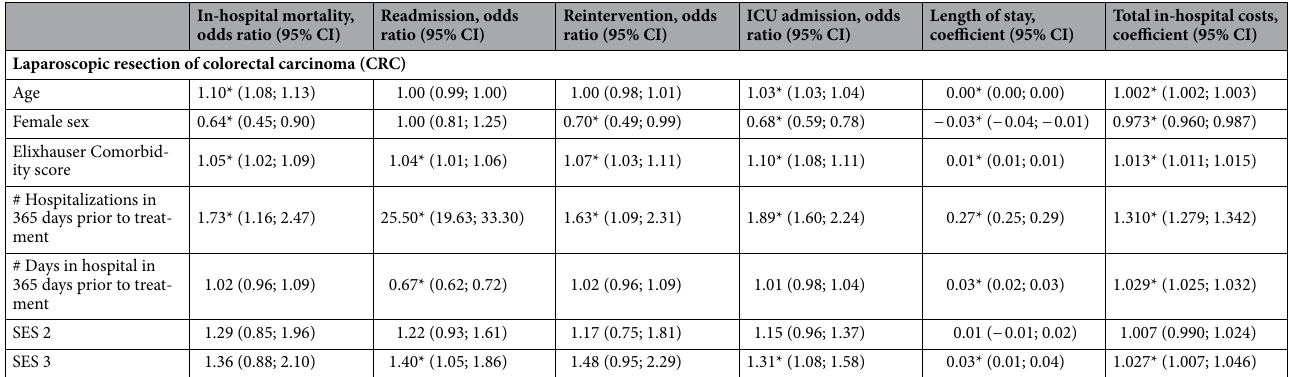
In-hospital mortality, odds ratio (95% CI)